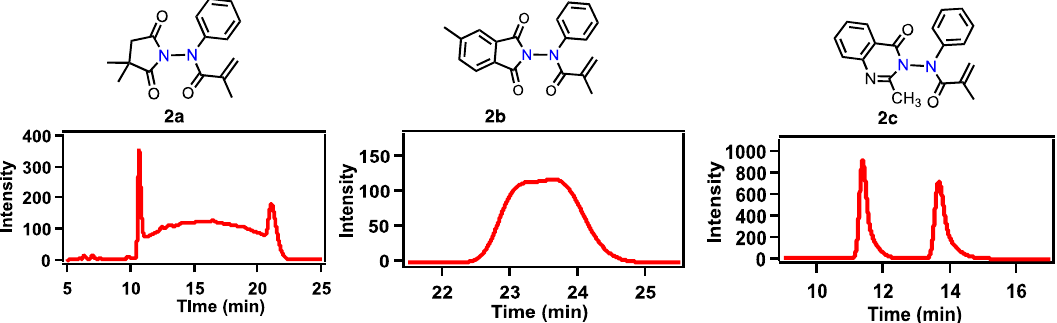
Figure 2. HPLC analysis of hydrazides 2a – c on a chiral stationary phase. HPLC condition: Figure 2. CHIRALPAK ® IC, mobile phase hexane:2-propanol 70:30, flow rate: 1.0 mL / min, retention times 10.6 min and 20.9 min; 2b CHIRALPAK ® IC, mobile phase-hexane:2-propanol 70:30, flow rate: 0.8 mL / min, HPLC condition; broad peak from 22.4–25.0 min; 2c CHIRALPAK ® AD-H, mobile phase hexane:2-propanol 70:30, flow rate: 0.8 mL / min, retention times 11.4 min and 13.7